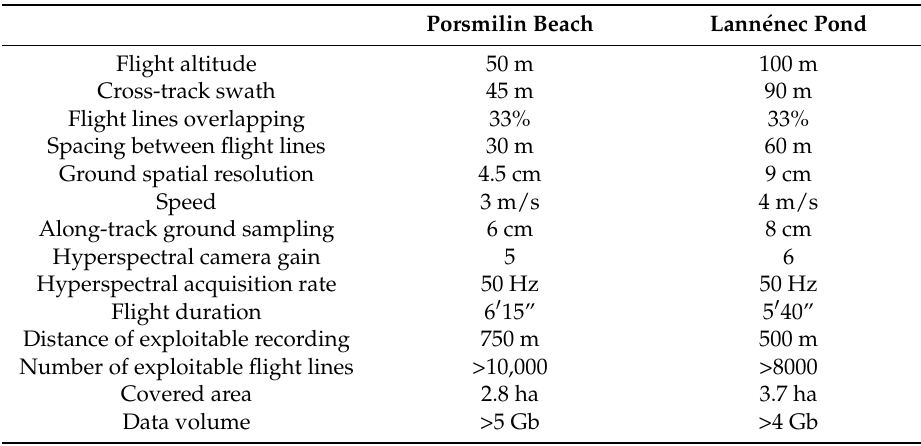
Table 2. Settings of the surveys at Porsmilin Beach and Lann é nec